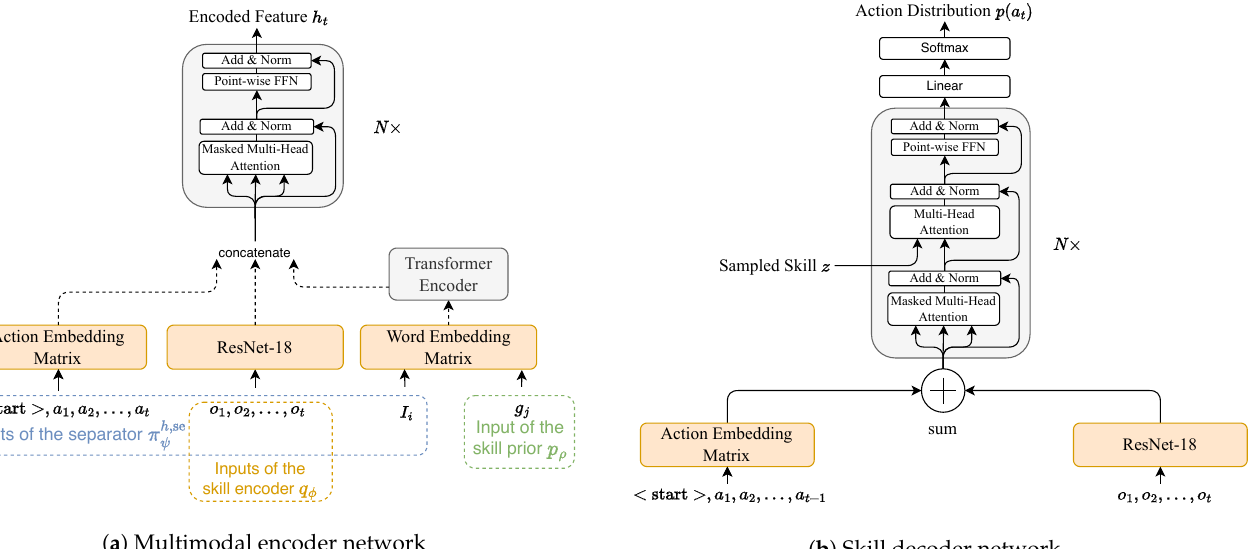
Figure 3. Network structures. ( a ) Multimodal encoder network structure of separator π h ,se ψ , skill prior p ρ , and skill encoder q φ , with different input options illustrated with colored boxes. ( b ) Skill decoder network structure with a transformer